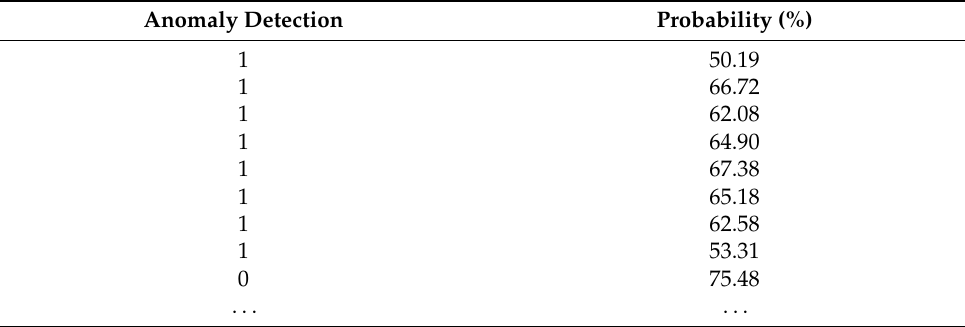
Table 3. Results of the one-class classification